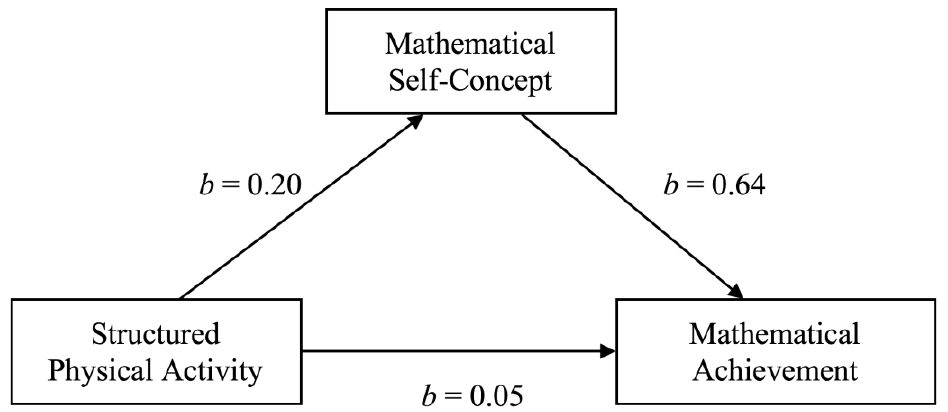
Figure 1. Mediational effect of time spent in structured physical activity (PA) on mathematical achievement by mathematical self-concept.